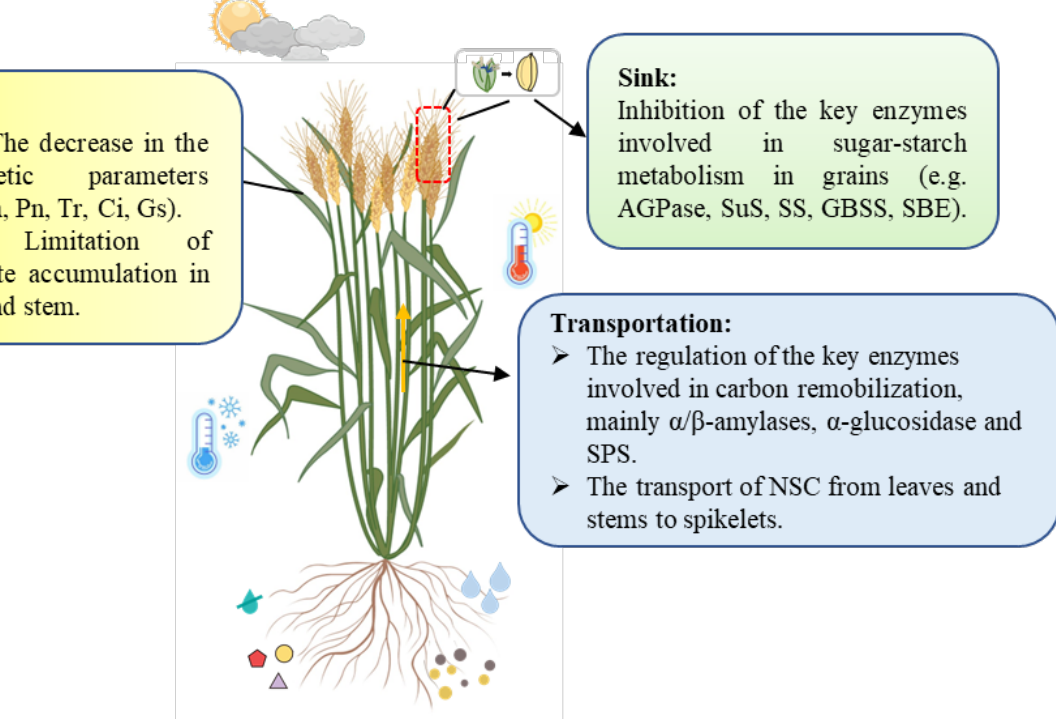
Figure 2. The effect of environmental stimuli on sources, transportation, and sinks during grain filling. Fv/Fm: photosynthetic efficiency; Pn: photosynthetic rate; Tr: transpiration rate; Ci: intracellular CO2 concentration; Gs: stomatal conductance; AGPase: ADP-glucose pyrophosphorylase; SuS: sucrose synthase; SS: soluble starch synthase; GBSS: granule-bound starch synthase; SBE: starch branching enzyme; SPS: sucrose-phosphate synthase. This figure was created with the help of Figdraw (www.home-for-researchers.com, accessed on 1 November 2022).